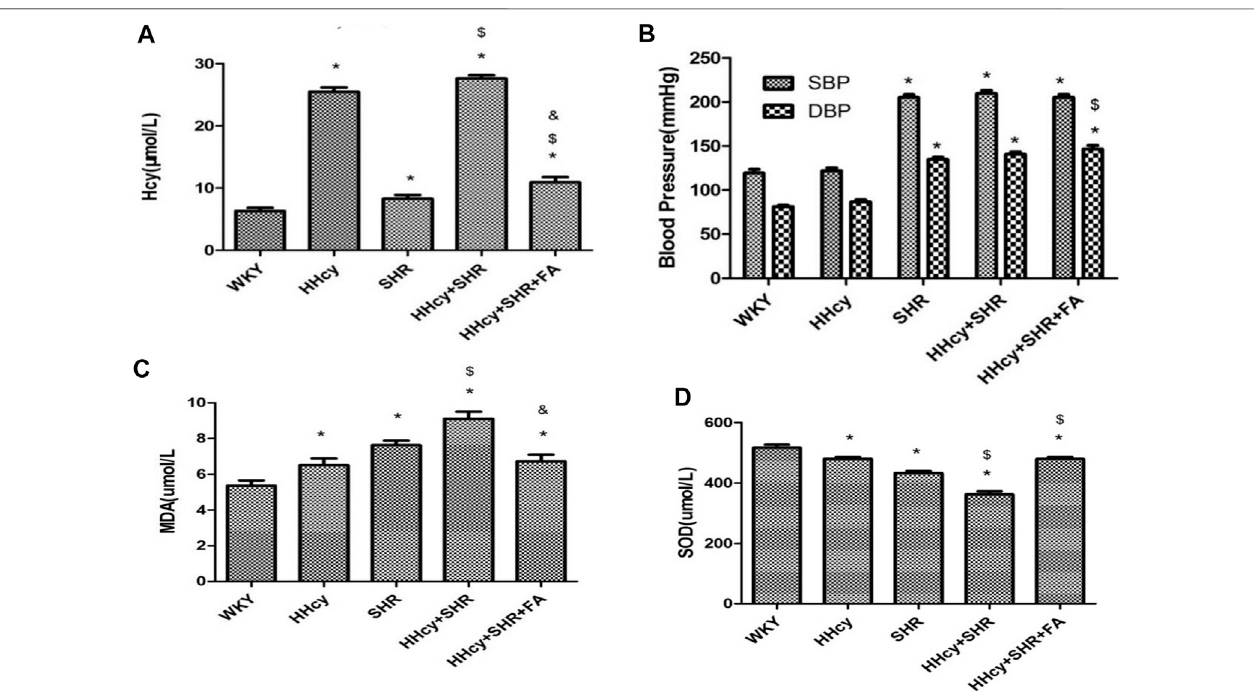
FIGURE 2 | The levels of homocysteine (Hcy), superoxide dismutase (SOD), malondialdehyde (MDA), systolic blood pressure (SBP), and diastolic blood pressure (DBP) in Wistar-Kyoto (WKY) group, hyperhomocysteinemia (HHcy) group, spontaneously hypertensive rat (SHR) group, HHcy + SHR group, and HHcy + SHR + folate (FA) group. (A) The levels of Hcy. (B) The levels of SBP and DBP. (C) The levels of MDA. (D) The levels of SOD. Values represent means ± SD (* p < 0.05 vs. the WKY group, $ p < 0.05 vs. the SHR group, & p < 0.05 vs. the HHcy + SHR group, n (cid:1)